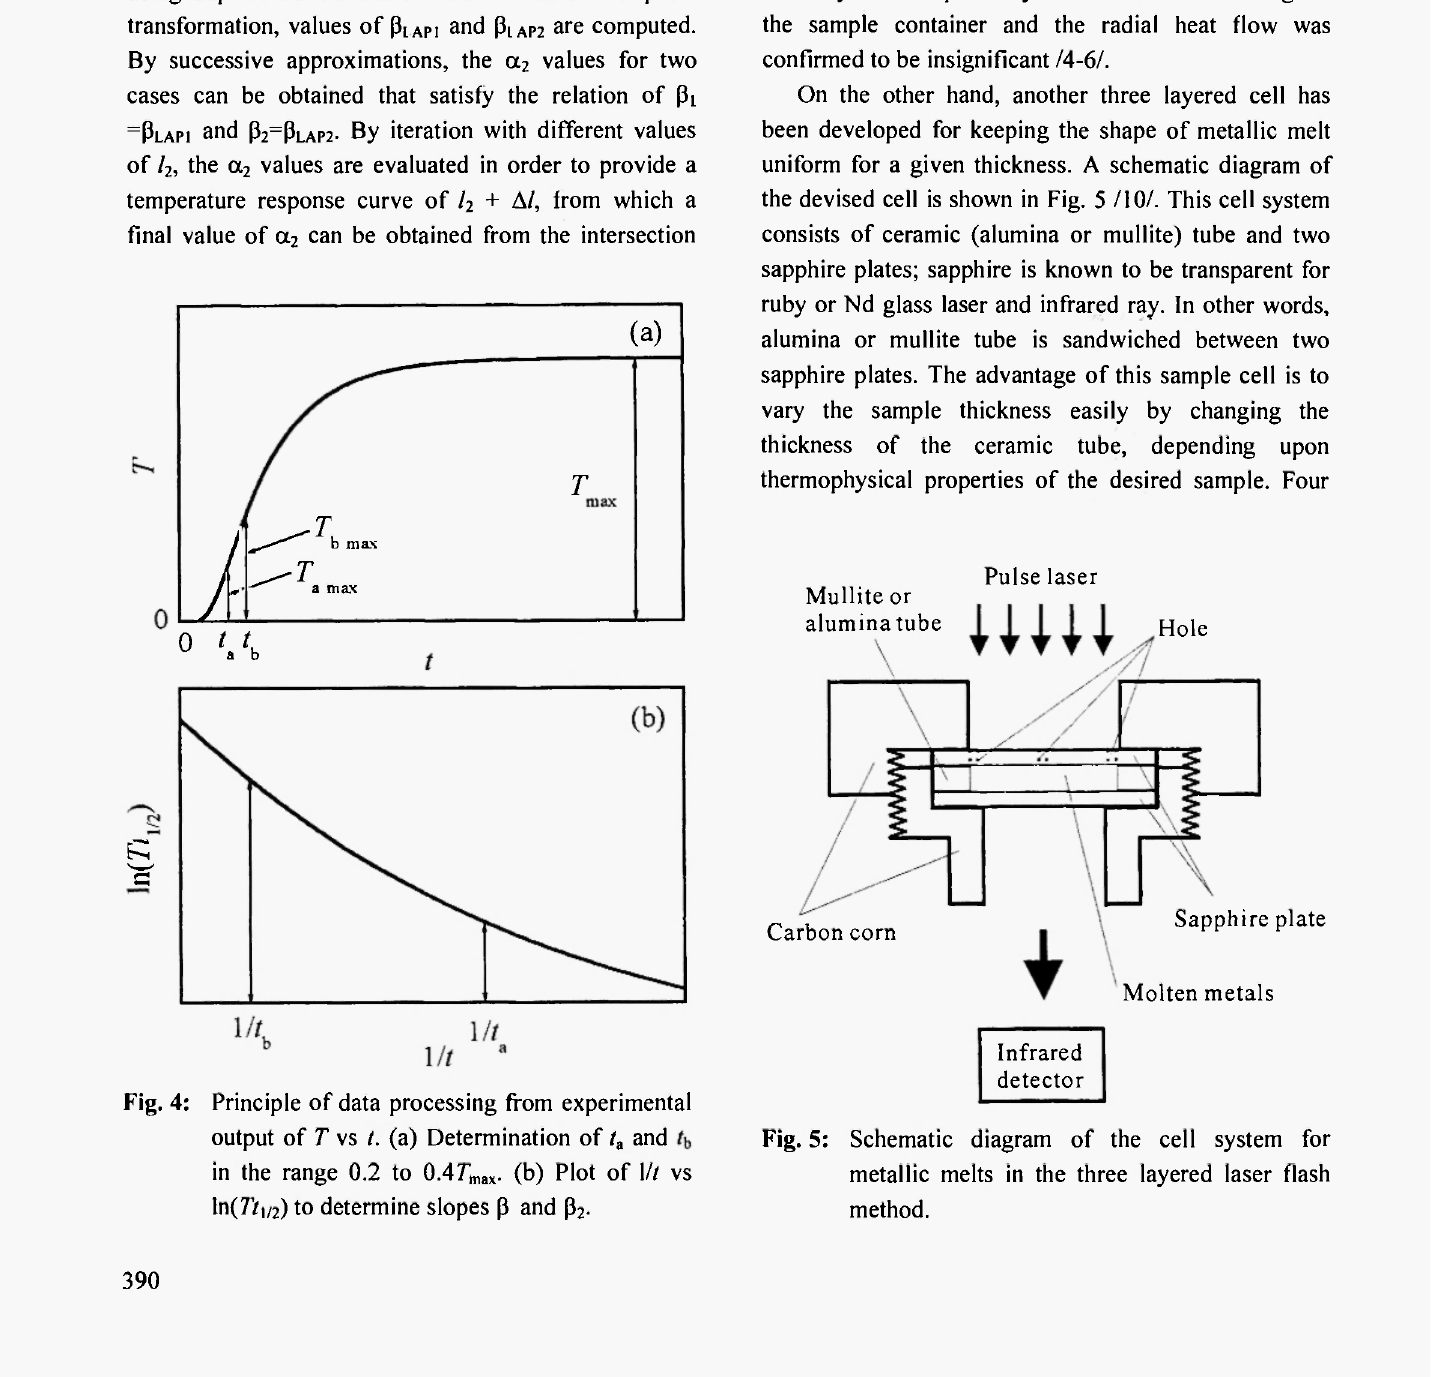
Fig. 5: Schematic diagram of the cell system for metallic melts in the three layered laser flash